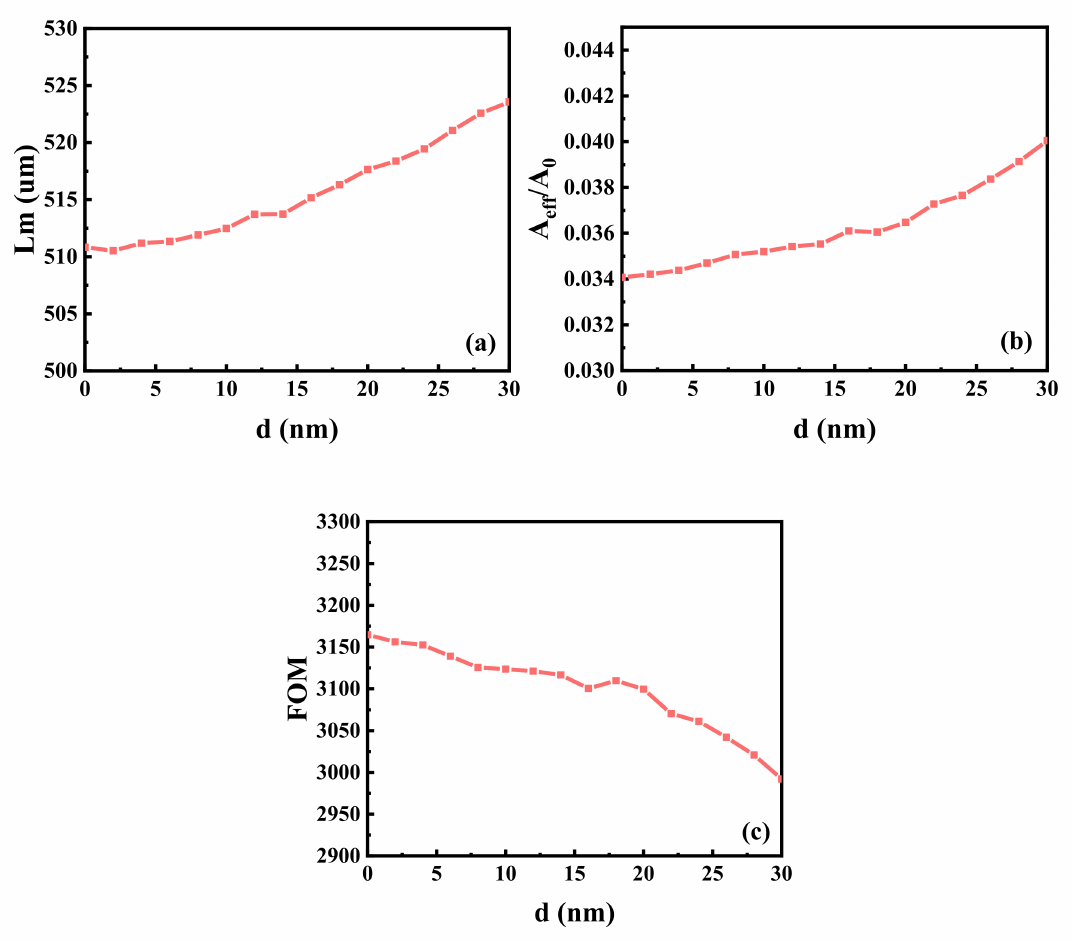
Figure 7. Dependence of mode properties on d : ( a ) propagation length L m ; ( b ) A ef f / A 0 ; ( c ) the figure of merit FOM . Here, r = 45 nm, h = 13 nm, rw = 15 nm, α = 60 ◦ , θ = 0 ◦